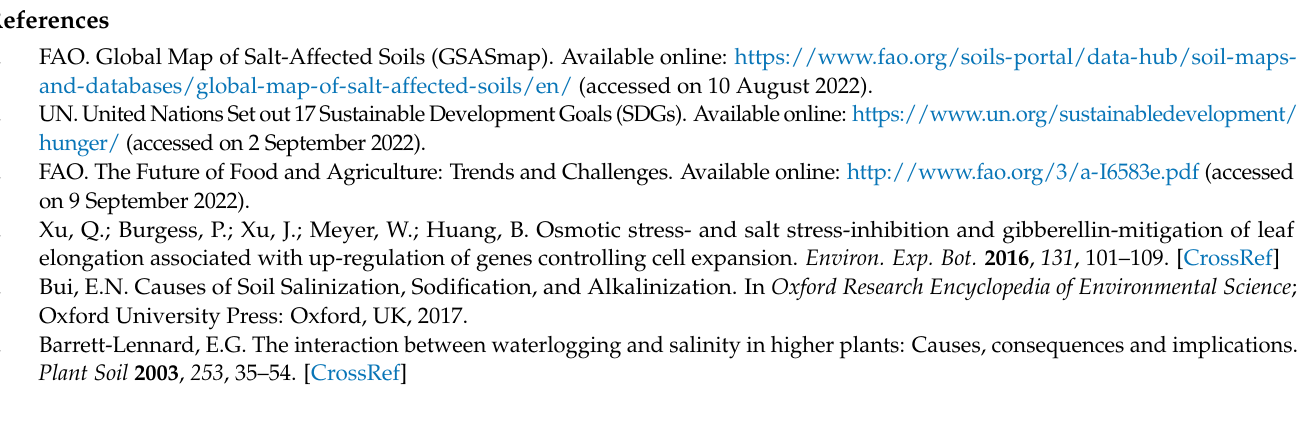
total chlorophyll content. Table S1: Variance analysis tables. Table S2 Loading values and percentage contribution of variables on the axis identified by the principal component analysis (PCA) for all cultivars under control and saline